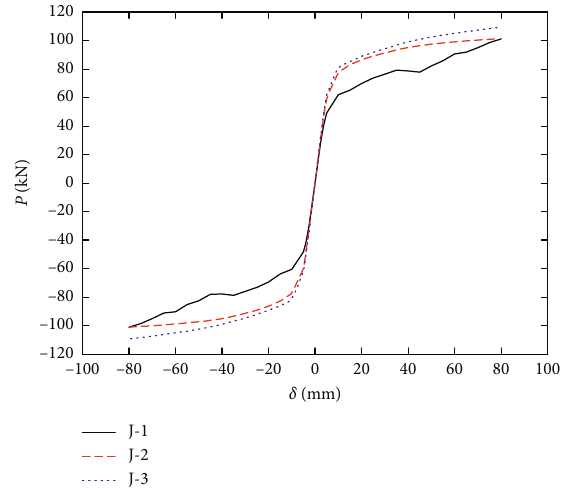
Figure 12: Skeleton curves of the joints.